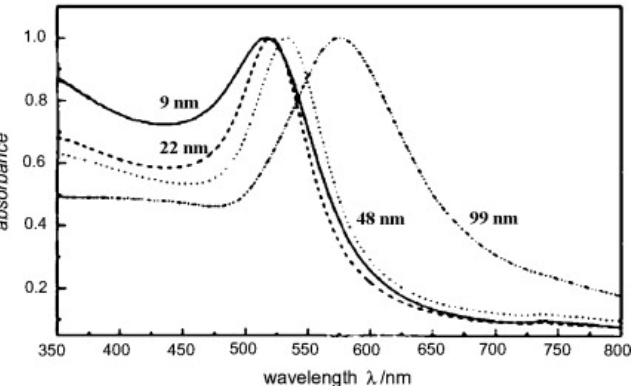
Figure 7. Surface plasmon resonance for different sizes of gold nanoparticles. Reprinted with permission from [38]. Copyright 1999 American Chemical Society.